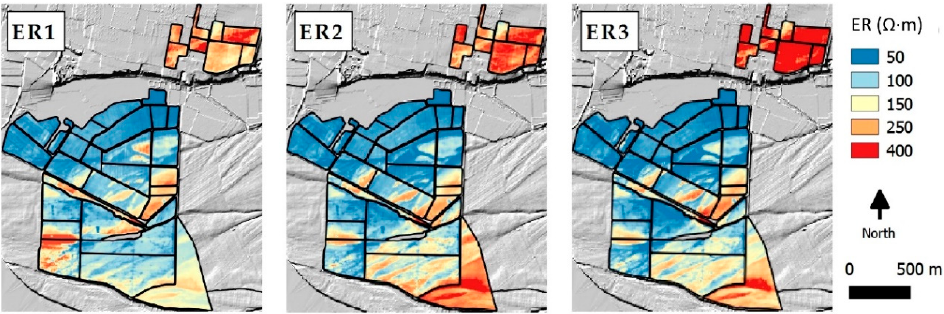
Figure 3. Maps of electrical resistivity at three pseudo-depths (ER1 = 0–50 cm, ER2 = 0–100 cm, ER3 = 0–180 cm), interpolated by ordinary kriging. Table 1. Descriptive statistics of proximal sensing and data of soil typological units (PES1 and PES3: